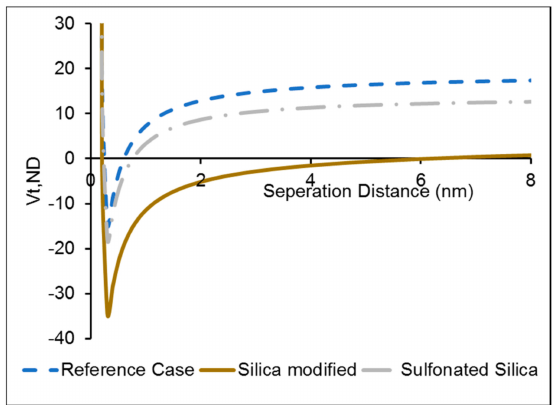
Figure 13. Dimensionless form of Interaction potential for interaction between the fines and the berea mineral for reference case (no NP), berea treated with silica and berea treated with sulfonated